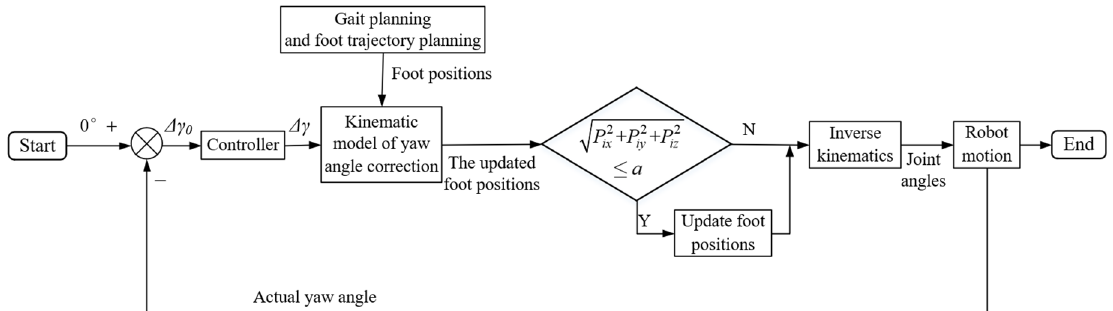
Figure 10. Flow chart of hexapod robot yaw angle correction algorithm. In the straight gait, the desired yaw angle of the robot is always 0°. In the process of ment can then be recalculated to adjust the walking direction (See Equation (10)). After robot walking, the feedback information of yaw angle can be obtained based on the IMU module. Compared with the expected yaw angle, the difference 0 γ D is obtained as the input of the controller, and the output of the controller is γ D , which is the variable in the previously proposed kinematics model of yaw angle correction for the robot. In the pro- gram, sampling is done every 10 ms.